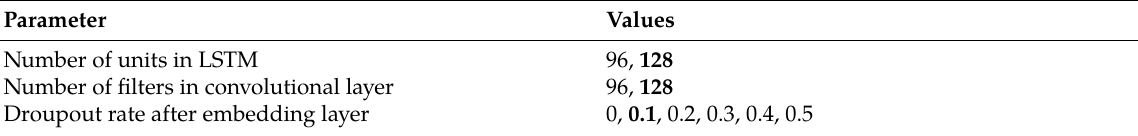
Table 1: Network parameter combinations tested using grid